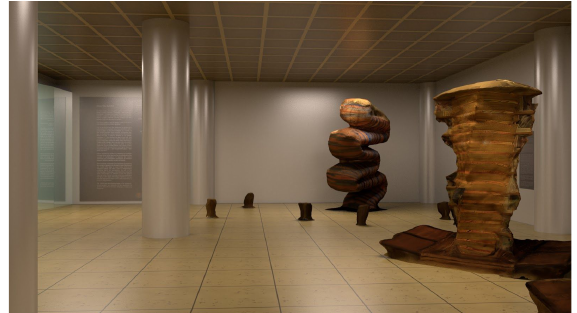
Figure 5. VR Environment showing exhibits